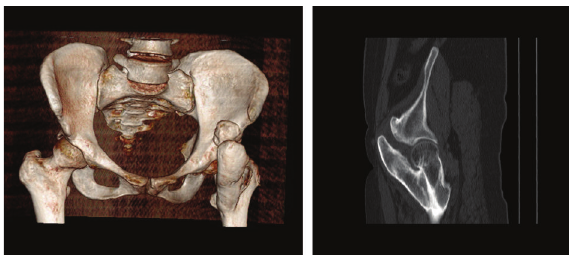
Figure5:Histologicalexaminationofthespecimenshowingmature osteoid under 40x magnification.